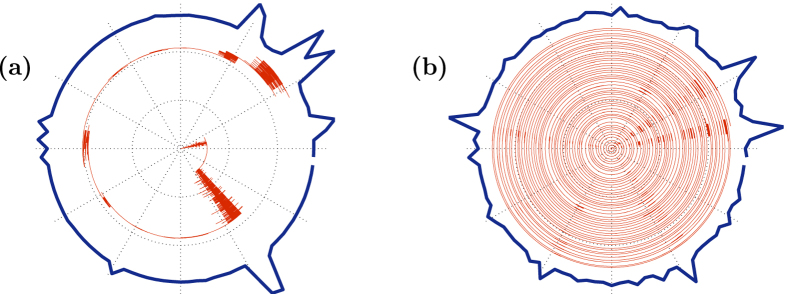
Simulated trajectory of a particle on a disordered-ring.The number of sites is N = 100 and the disorder strength is σ = 5. The radial direction is time and the angle is the position. (a) For small affinity (s = 0.88) the dynamics is over-damped. (b) For large affinity (s = 2.97) the dynamics is under-damped. The outer thick line is the steady-state distribution (see Methods).